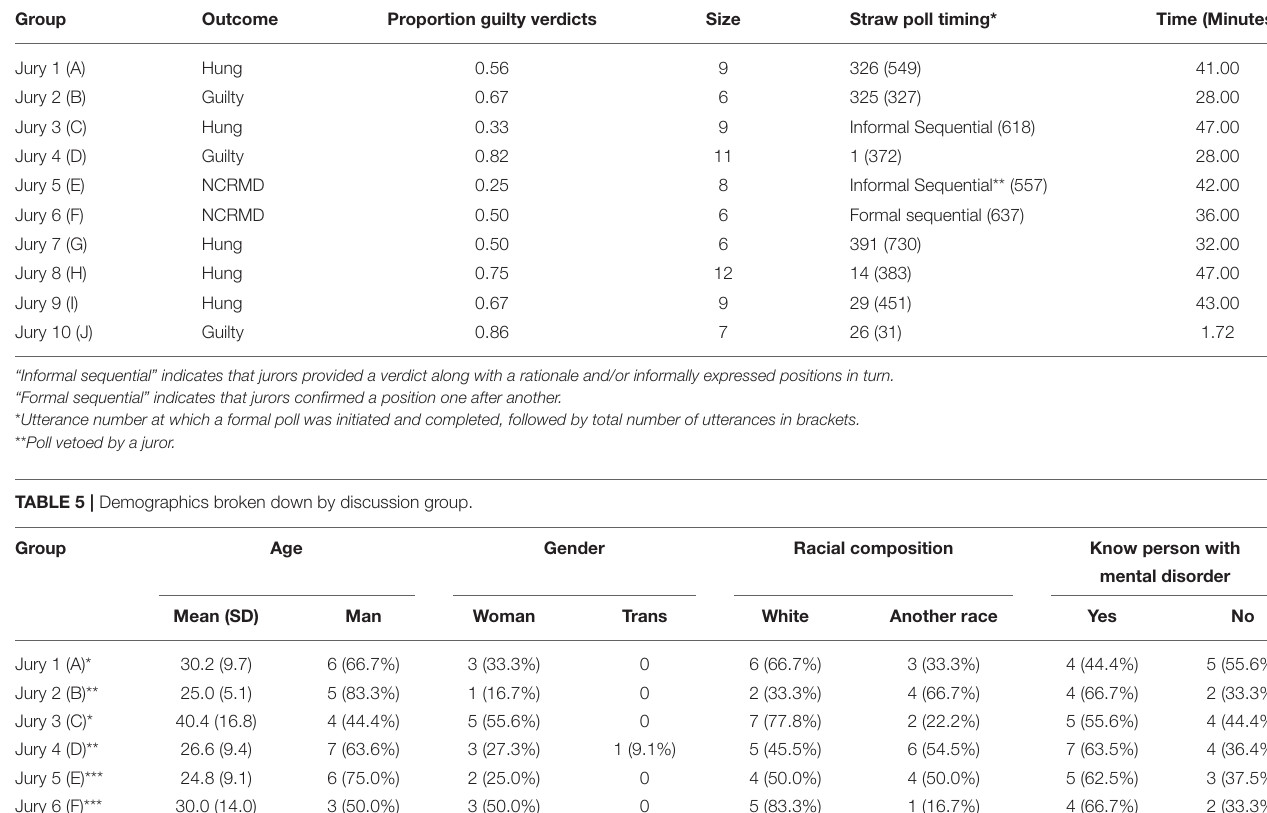
TABLE 4 | Group characteristics broken down by discussion group.